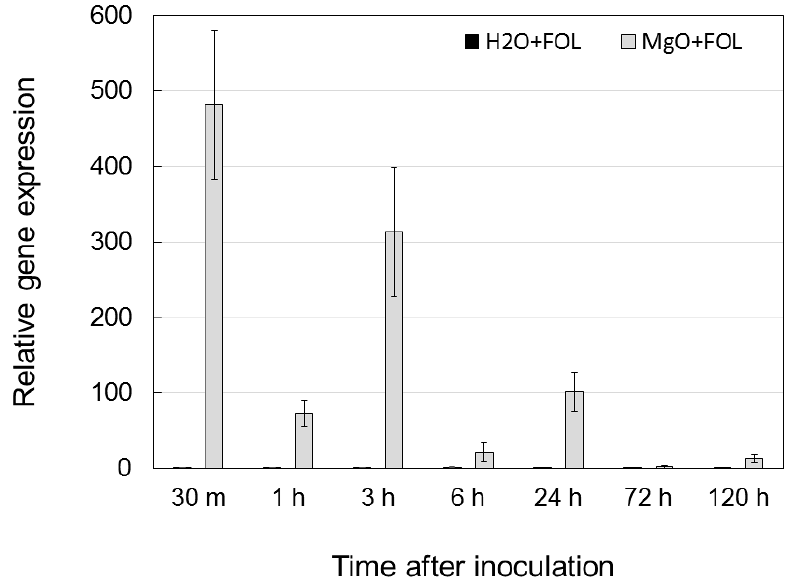
Figure 7. Time course of SlGRP4 expression in tomato roots pretreated with MgO NPs and challenge-inoculated with Fusarium oxysporum f. sp. lycopersici .